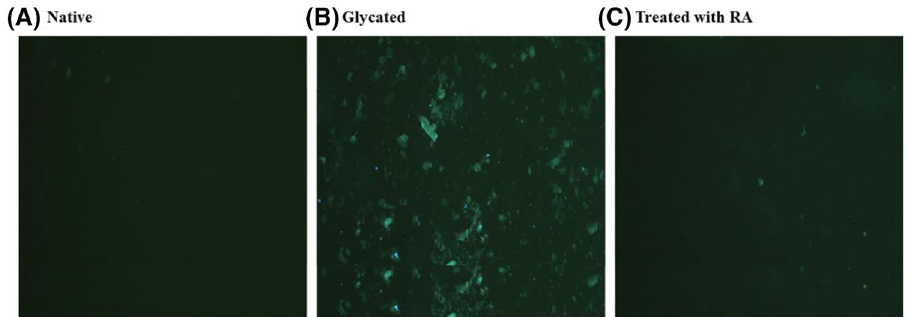
Figure 4. Fluorescence microscopic imaging, the native DNA ( A ), the glycated DNA ( B ), and the glycated DNA in the presence of 25 μM RA ( C ).